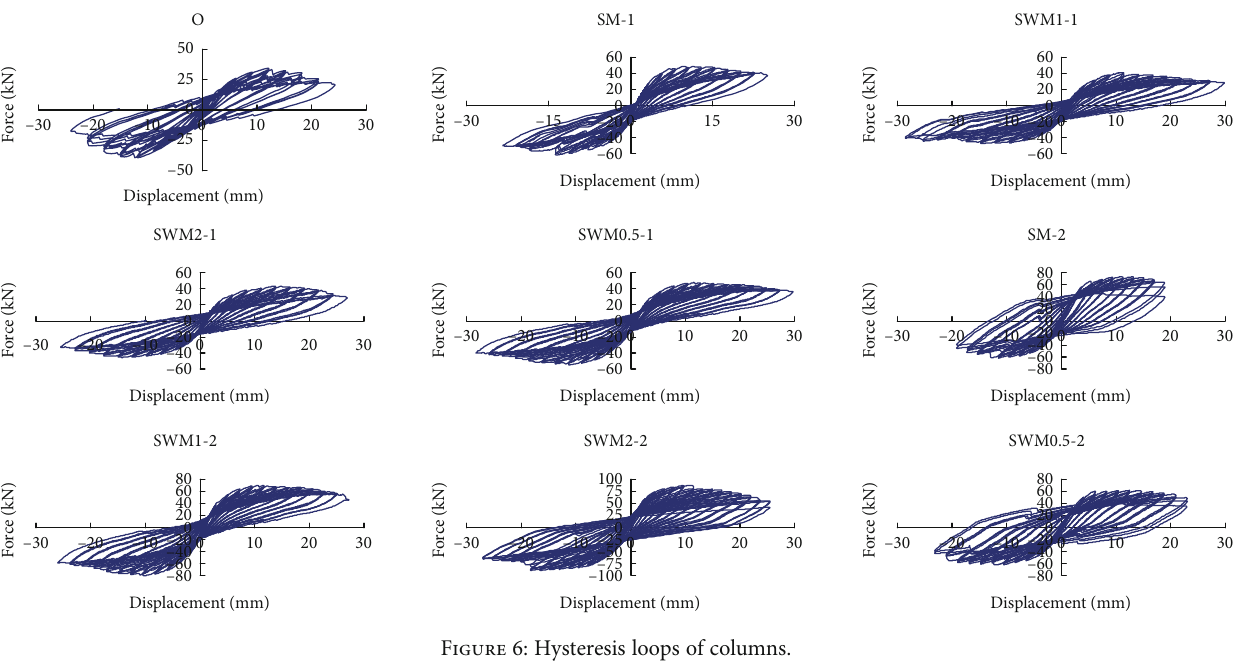
Figure 6: Hysteresis loops of columns.